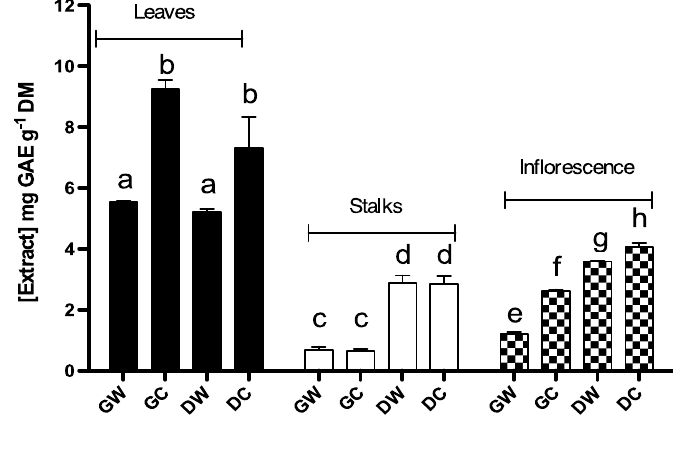
Figure 1. Total phenolic contents of different Cc extracts expressed in mg of gallic acid per gram of plant used to obtain the extract (mg GAE g − 1 DM). Each value represents the mean ± S.D. of three determinations. At least one same letter means no significant differences at P ≤ 0.05. Abbreviations: GW: green wild; GC: green cultivated; DW: dry wild; DC: dry